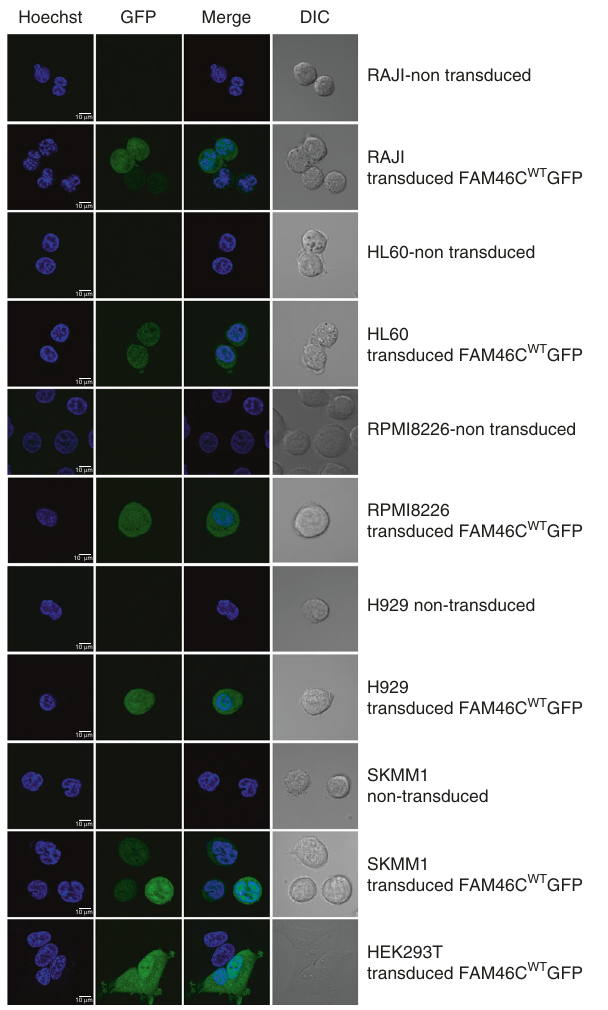
Fig. 2 FAM46C shows both nuclear and cytoplasmic localization. HEK293T, RPMI826 (MM), H929 (MM), SKMM1 (MM), HL60 (promyelocytic leukemia) and Raji (B-cell lymphoma) cell lines were transduced with constructs encoding the FAM46C WT – GFP fusion gene. Non-transduced cells were used as a control. Fluorescence images for GFP and Hoechst nucleic acid stain, as well as merged images, are shown. Scales bars (10 µ m) are shown for each set